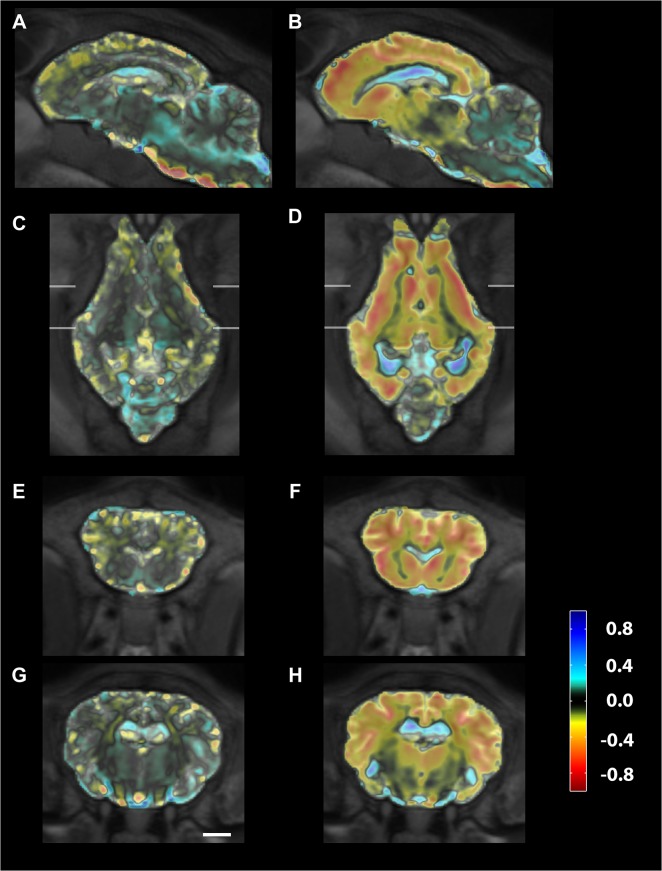
Map of mean volume changes in Batten disease affected sheep.Volume changes are shown for control sheep (A, C, E, G) and Batten disease affected sheep (B, D, F, H) in sagittal (A, B)), horizontal (C, D) and two coronal planes (E-H), one at the level of the striatum (E, F), the other at the level of the thalamus (G,H). Scale bar in G is 1cm and the colour scale indicates volume change as ml/year.